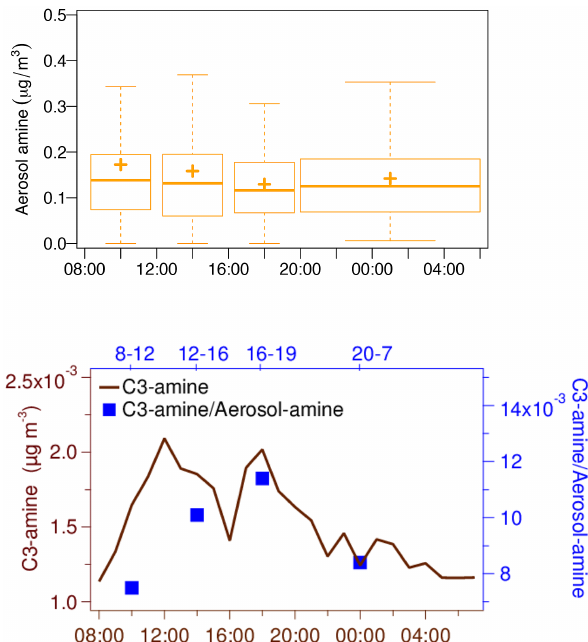
Figure 6. (Upper panel) Average daily variation of aerosol phase concentration (µgm − 3 ) of primary amines in submicron particles collected on PTFE filters and analyzed with FTIR during the SOAS campaign. The horizontal solid lines indicate the median, plus signs indicate the mean, the boxes extend from the 25th to 75th percentile, and the whiskers span the interquartile range. (Lower panel) Temporal variation of the averaged gas-phase C3-amines (brown line) and the ratio of C3-amines over the aerosol-phase aliphatic amines (blue squares) during the SOAS campaign. The unit of gas-phase C3-amine concentrations was converted frompptv to µgm − 3 (1pptv = 0.41ngm − 3 ) to be compared with aerosol- phase amines. Since C3-amines dominated for most of the SOAS campaign (Figs. 2 and 3), C3-amines can be representative of the total gas phase amine